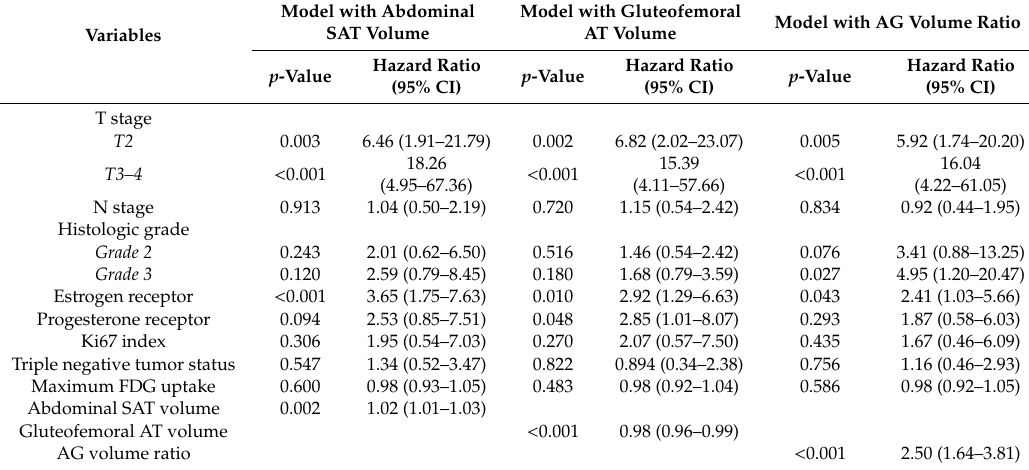
Table 3. Multivariate models for recurrence-free survival.